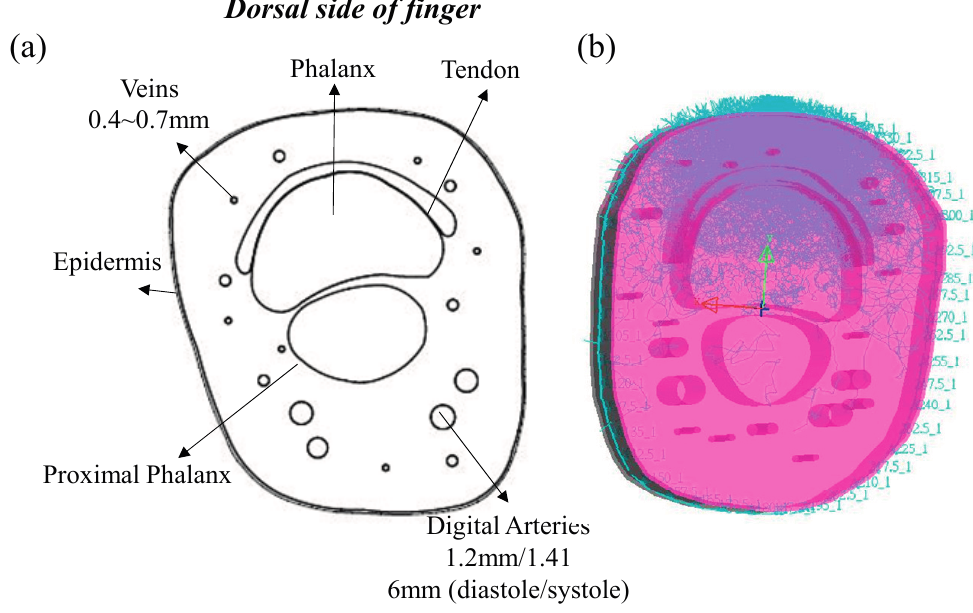
Figure 1. ( a ) Cross-section of the finger base and ( b ) the optical human tissue simulation when the light source was placed at